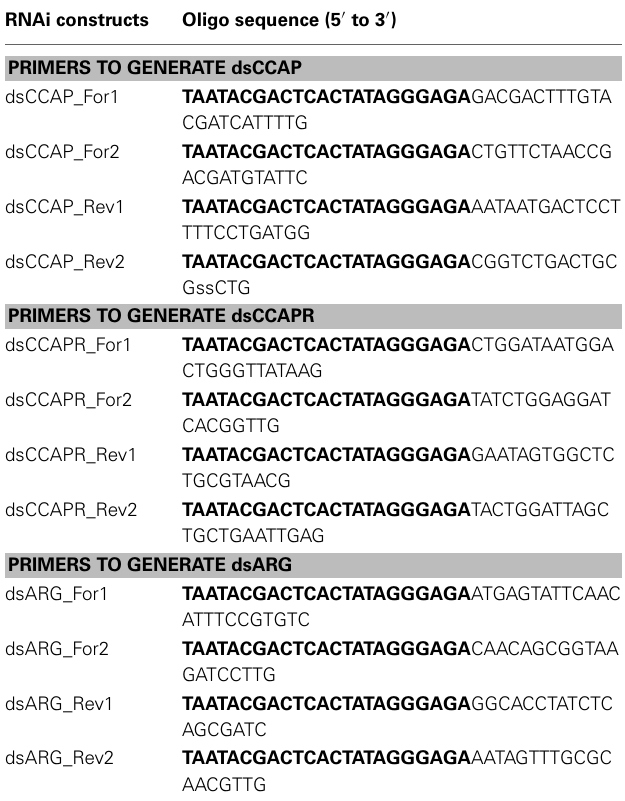
Table 2 | Primers for generating templates of dsCCAP, dsCCAPR or the ampicillin resistance gene